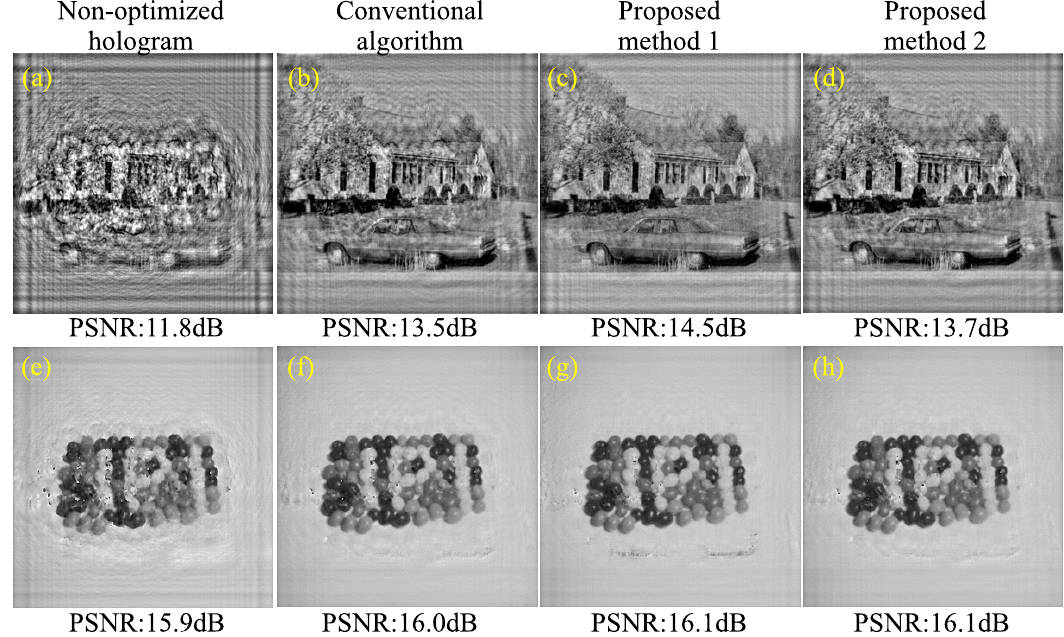
Figure 5. Reconstructed amplitude images ( upper row ) and phase images ( bottom row ) obtained from a non-optimized hologram and optimized holograms,